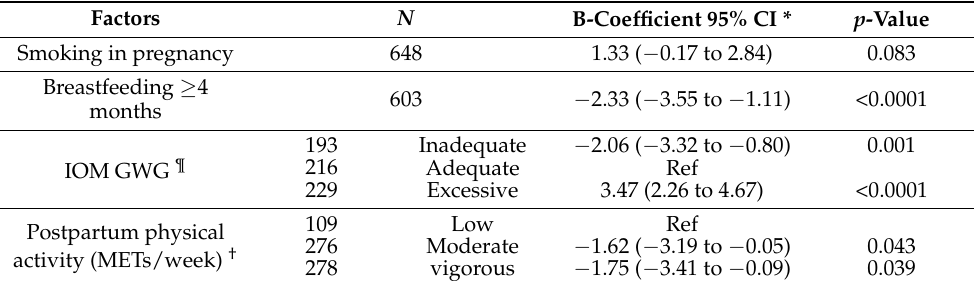
Table 2. Adjusted multiple linear associations between significant protective factors from model A and postpartum weight retention (continuous outcome).